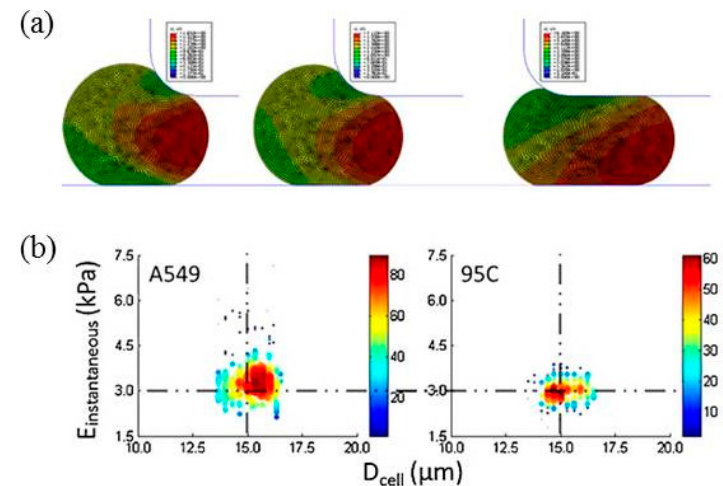
Figure 7. ( a ) Numerical simulations of the cellular entry process including initial jump into the channel (left), cellular creep response (middle) and creep response termination (right) at the transitional position. ( b ) Scatter plots of E instantaneous (Instantaneous Young’s Modulus) vs. D cell for A549 cells and 95C cells (two lung cancer cell lines), indicating noticeable differences in E instantaneous between these two cell types. Reproduced with permission from [47].